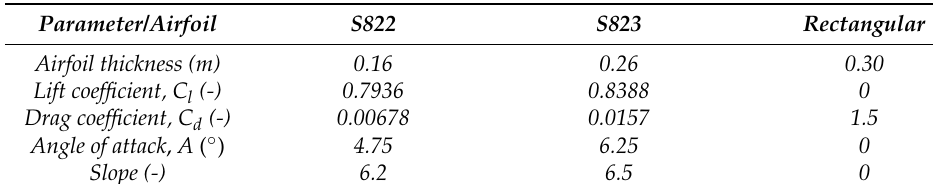
Table 2. Aerodynamic parameters of the selected airfoils.